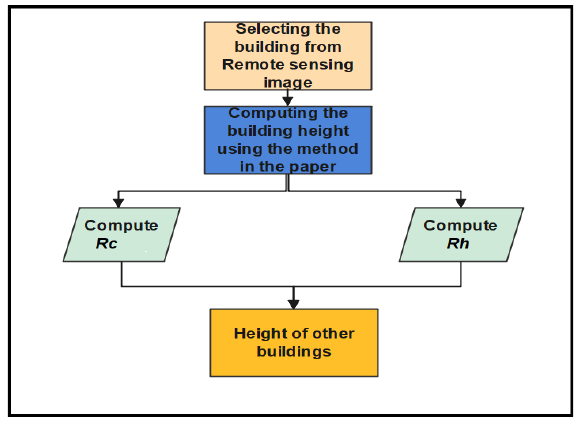
Figure 1. Height estimation of other buildings with the calculation made for the main building